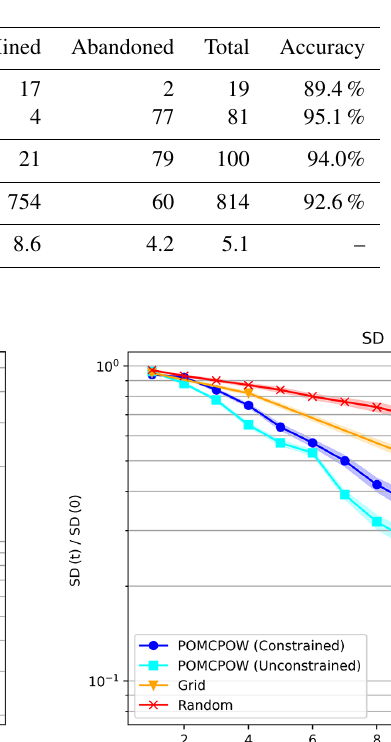
Table 5. Single-body, variable-location POMCPOW results without action constraints.